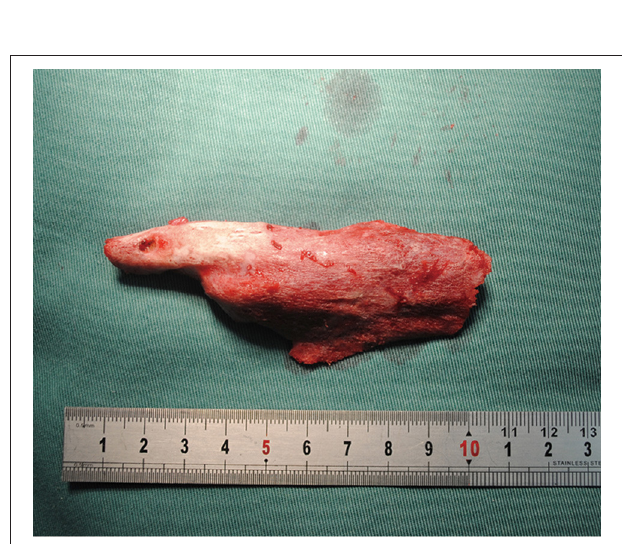
FIGURE 3 | Bony myositic mass excised is about 9 ×